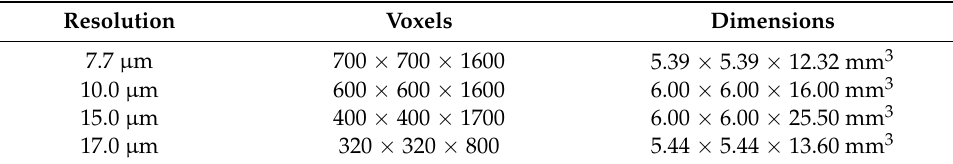
Table 2. Measurement parameters of the µ CT evaluation and resulting measuring dimensions.